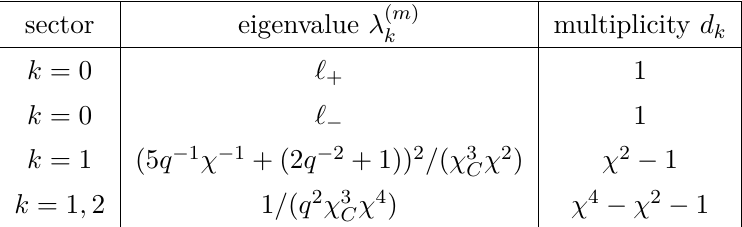
Table 2 . The list of eigenvalues and their degeneracies for the m = 4 reflected spectrum. We have set q = q = q to simplify A B